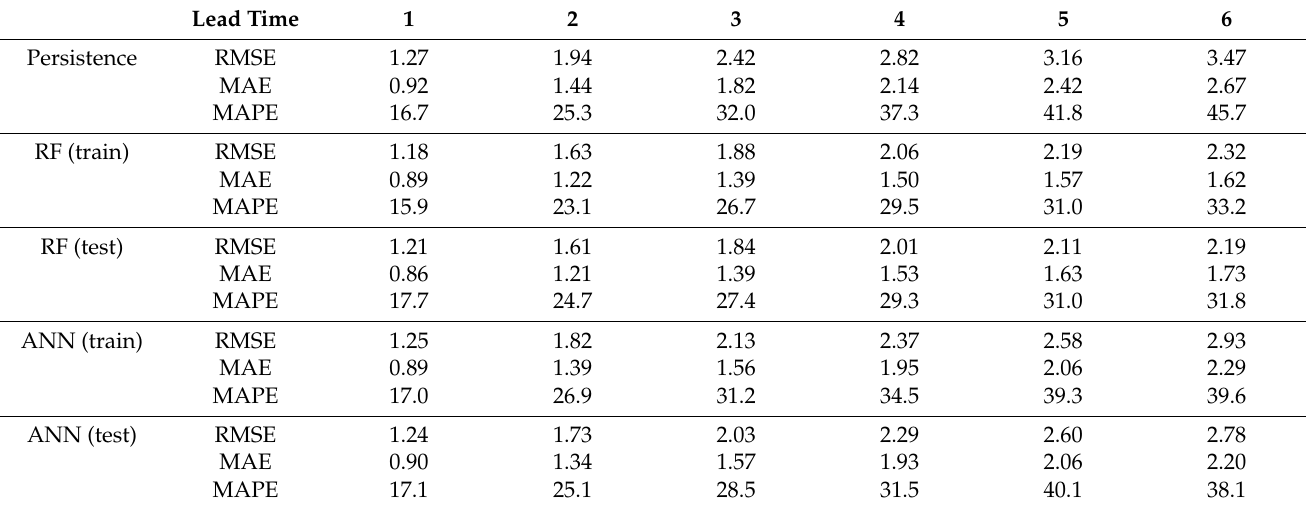
Table 5. The error criteria of the persistence model, the RF model, and the ANN